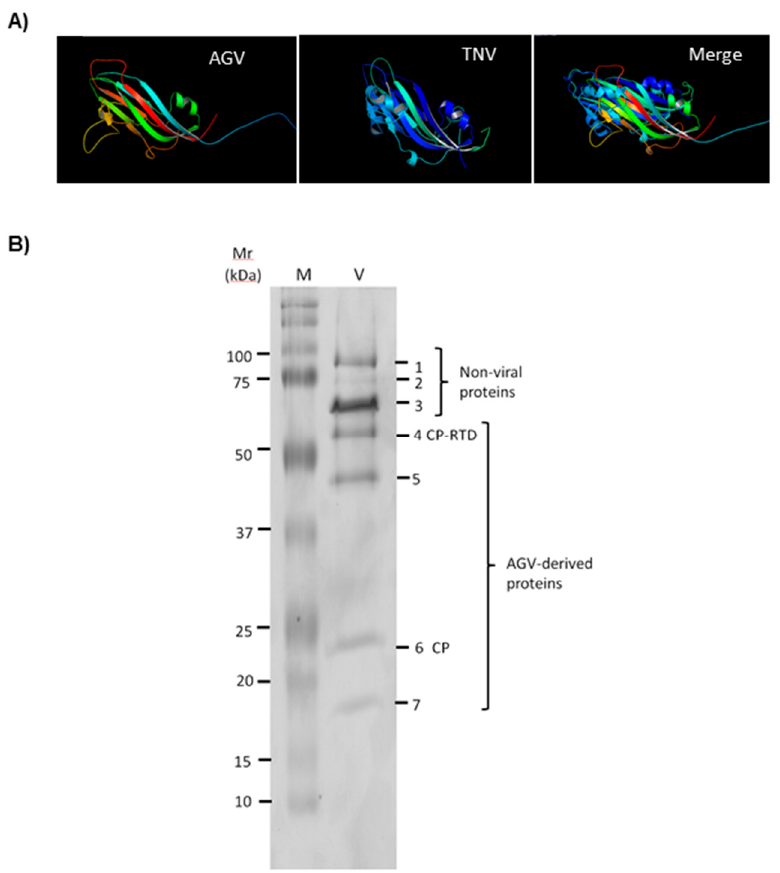
Figure 3. ApGlV2 capsid proteins. ( A ) The predicted structures of ApGlV2 (AGV) and tobacco necrosis virus (TNV) capsid proteins are similar. Homology modeling of tertiary protein structures of viral capsid protein for ApGlV2 and TNV (PBD:1C8N). Merge shows superimposed images of the two predicted CP structures with signature jelly ‐ roll ‐ like symmetric antiparallel β sheets. The images were generated using the LOMETS server. ( B ) Identification of ApGlV2 structural proteins. Purified virions (V; ~5 μ g) were subjected to sodium dodecyl sulfate polyacrylamide gel electrophoresis (SDS ‐ PAGE) (15% gel) and bands cut from the Coomassie brilliant blue ‐ stained gel. The seven bands (1–7) were isolated for peptide sequencing. M, molecular mass markers.